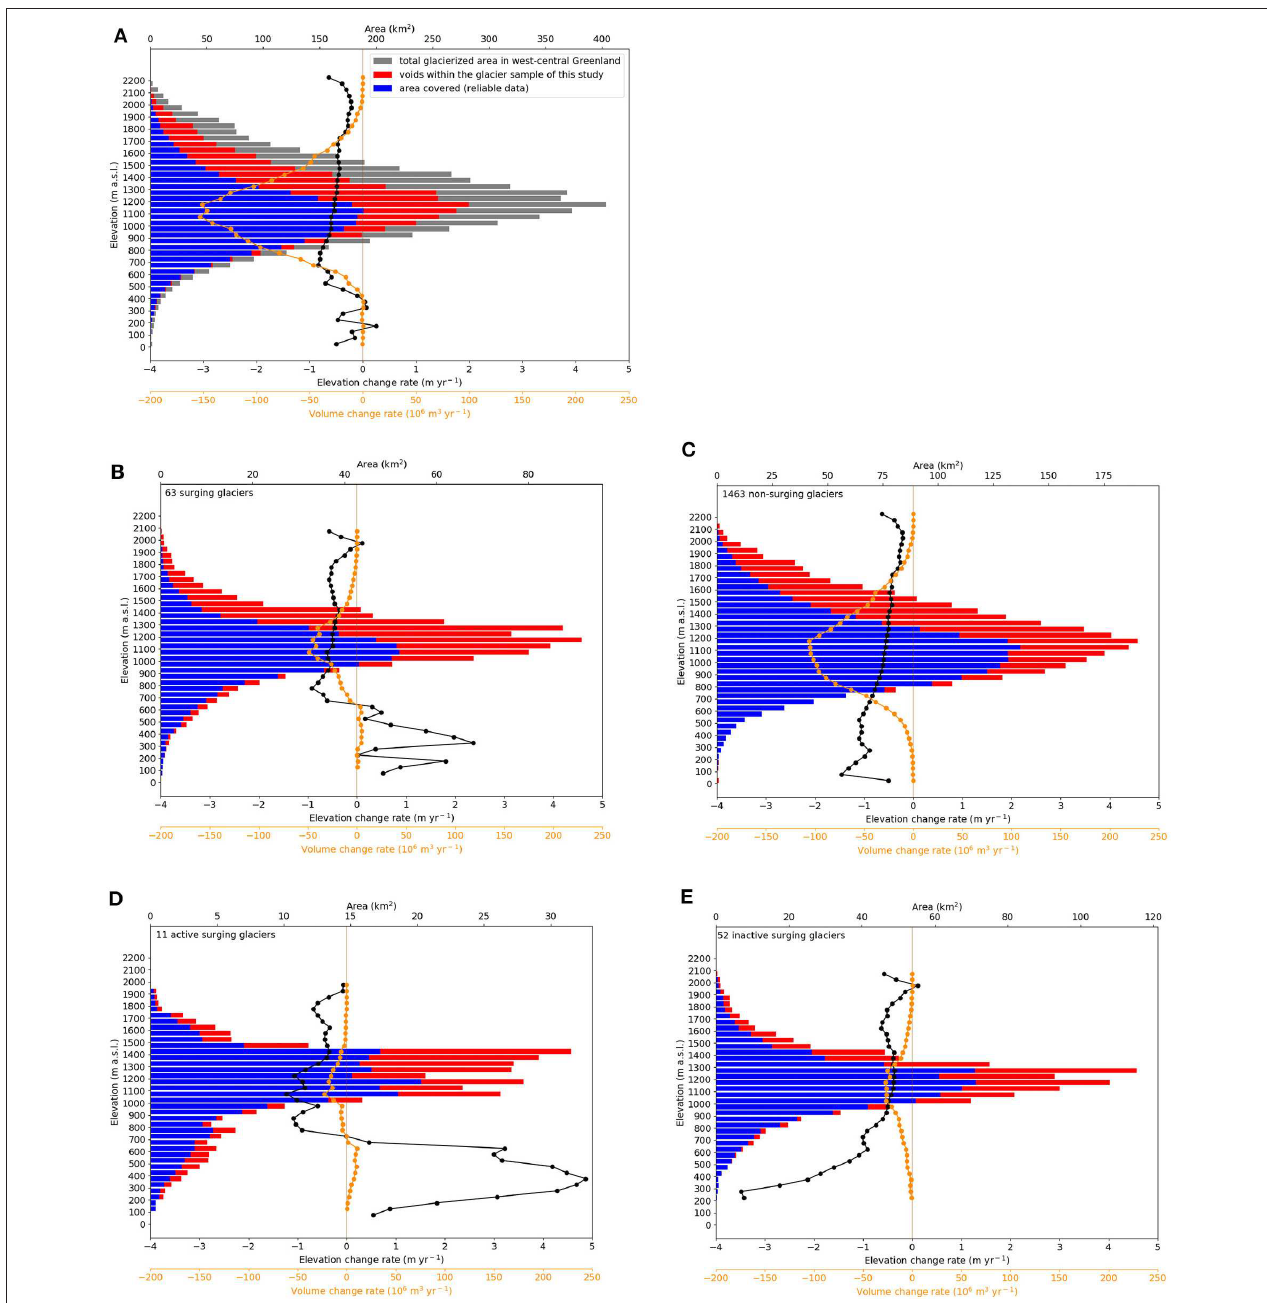
FIGURE 3 | Hypsometric glacier changes in west-central Greenland between 1985 and 2012. (A) The plot in the first row shows the glacier distribution with elevation (y-axis) for all glaciers in the region (gray) as well as for the investigated glacier sample with geodetic observations (blue) and original data voids (red). The average elevation and volumetric changes per elevation bin are shown as black and oranges lines, respectively, with corresponding y-axes. The second row shows the same plot but dividing the sample into glaciers with (B) and without (C) reported surge activities. In the third row, the surge glaciers (B) are divided into active (D) and inactive (E) subsamples based on corresponding indications in the elevation change